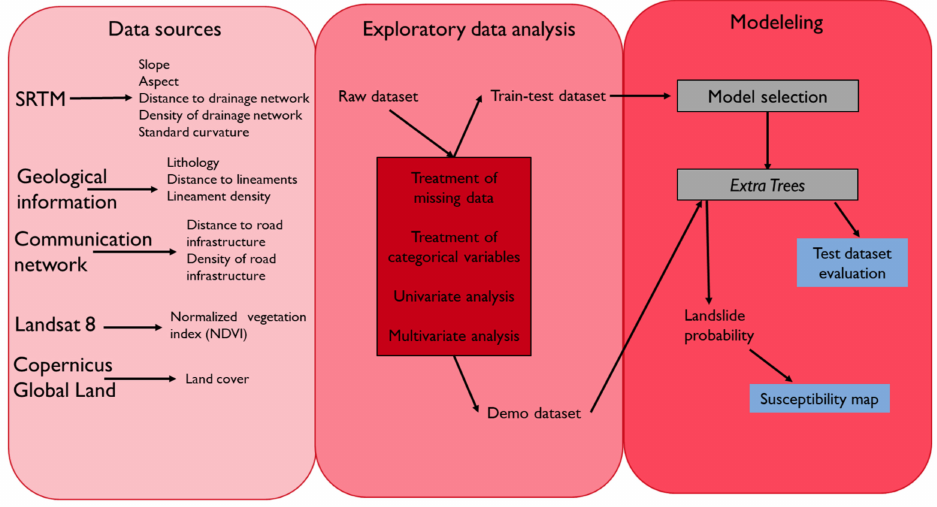
Figure 2. Workflow chart of the methodology perform to make the susceptibility map in this